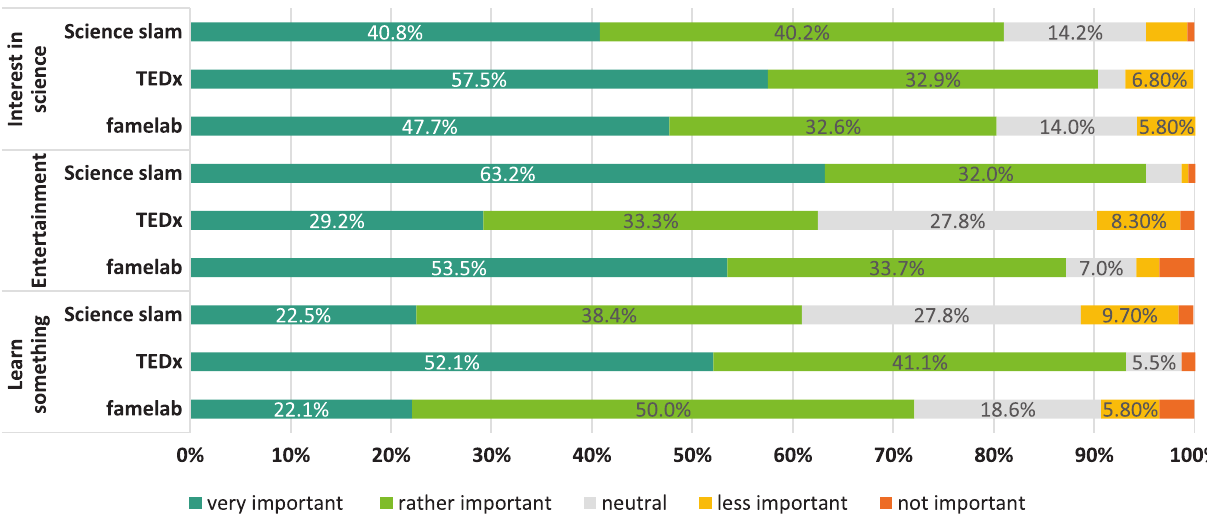
Figure 1. How important were the following aspects in your decision to come to the science slam/to the TEDxKIT Event/famelab today? Notes: Science slam: 444 ≤ n ≤ 458; TEDx: 72 ≤ n ≤ 73; famelab: n = 86). Values < 5% are not specified due to clarity